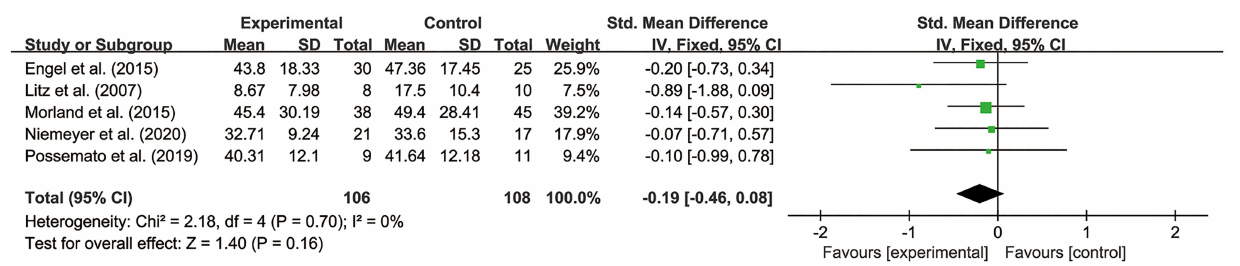
FIGURE 7 | Forest plot of results without the study with the largest sample